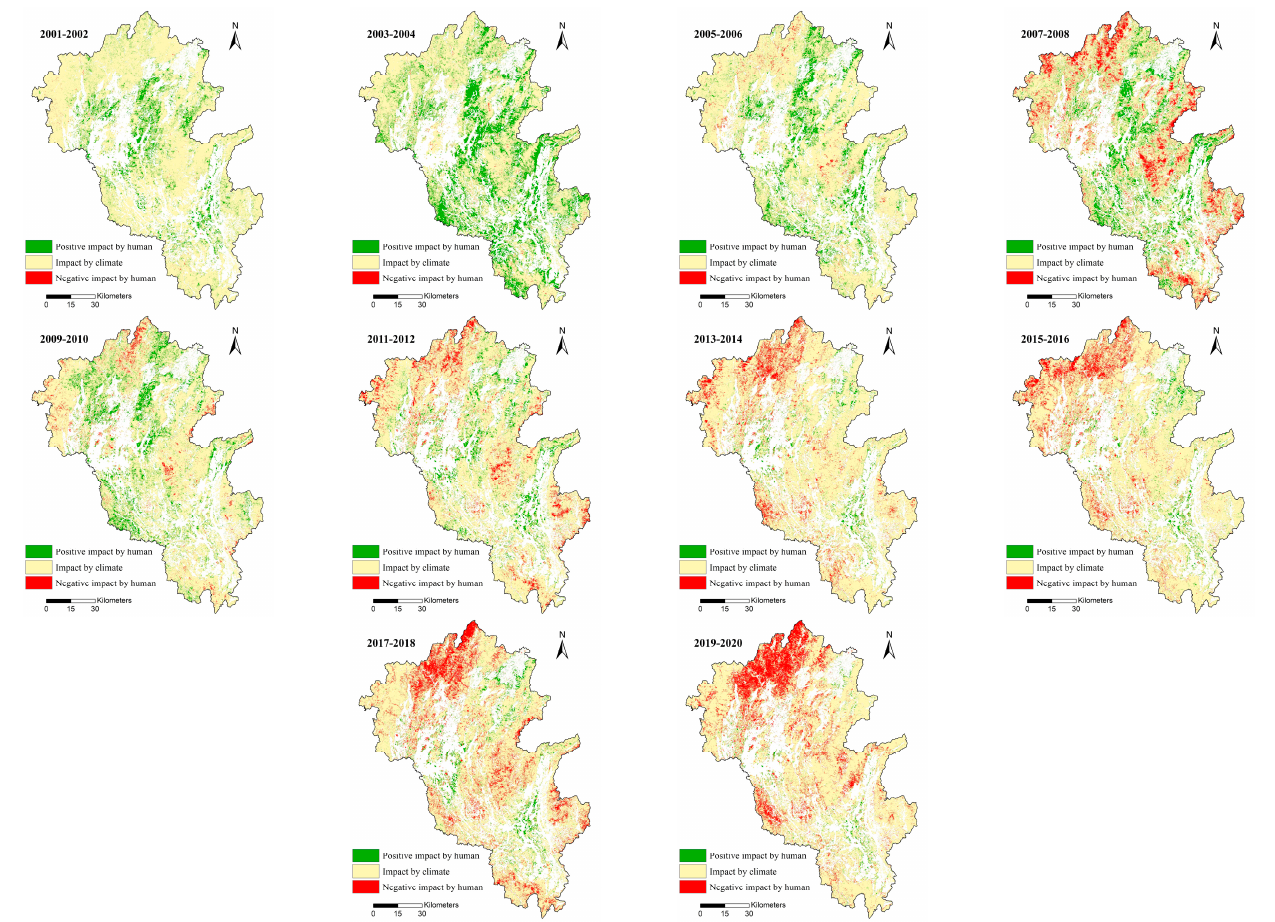
Figure 6. Distribution of dominant factors on vegetation growth every two years from 2000 to 2020. Table 4. Area percentage of different dominant factors on vegetation change